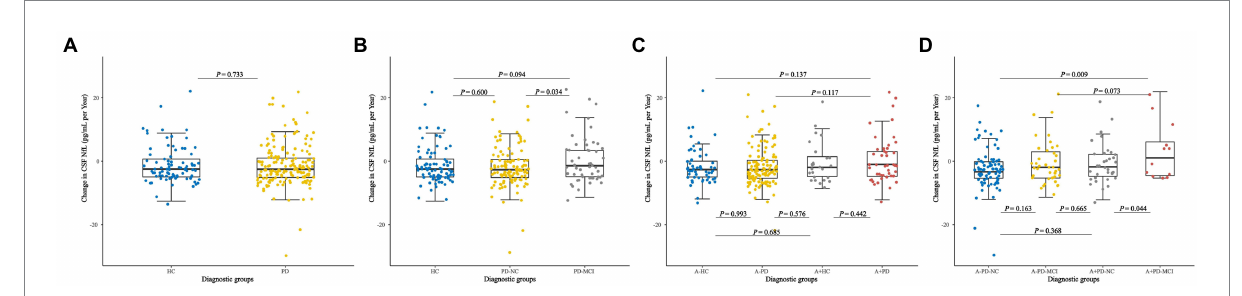
FIGURE 4 Longitudinal changes in CSF NfL of (A) Healthy controls and patients with de novo PD. (B) HC and de novo PD patients with different cognitive status. (C) HC and de novo PD patients in different amyloid status. (D) HC and de novo PD patients with different cognitive status in different amyloid status. CSF, cerebrospinal fluid; NfL, neurofilament light; HC, Healthy controls; PD, Parkinson’s disease; PD-NC, PD patients with normal cognition; PD-MCI, PD patients with mild cognitive impairment; A,